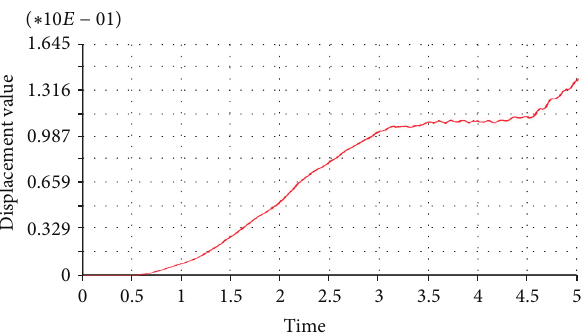
Figure7:Horizontaldisplacementofpoint1inmodel1;verticalaxisisvalueofdisplacement(meter),andhorizontalaxisistimeofearthquake